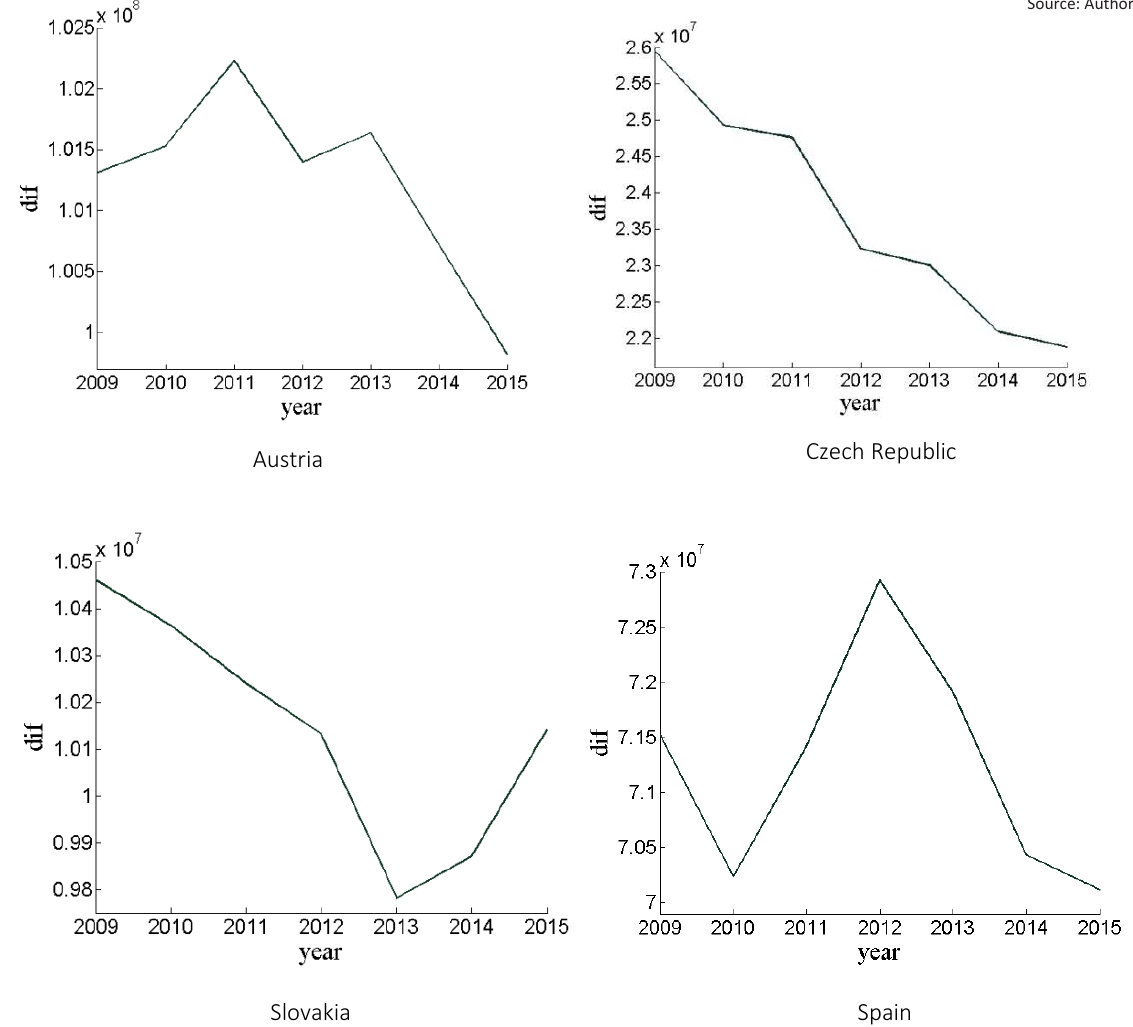
Figure 1. Differences of centroids in PLS variant of linear discriminant